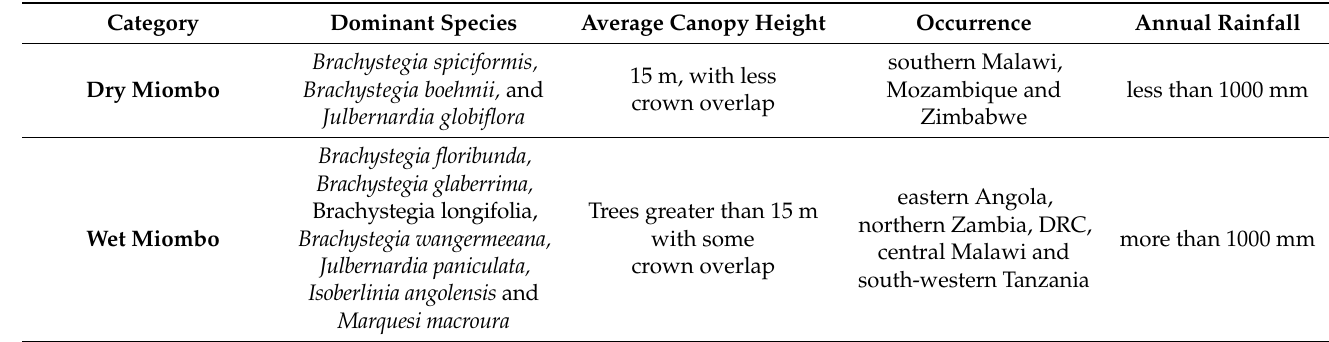
Table 1. Categorization of the Miombo